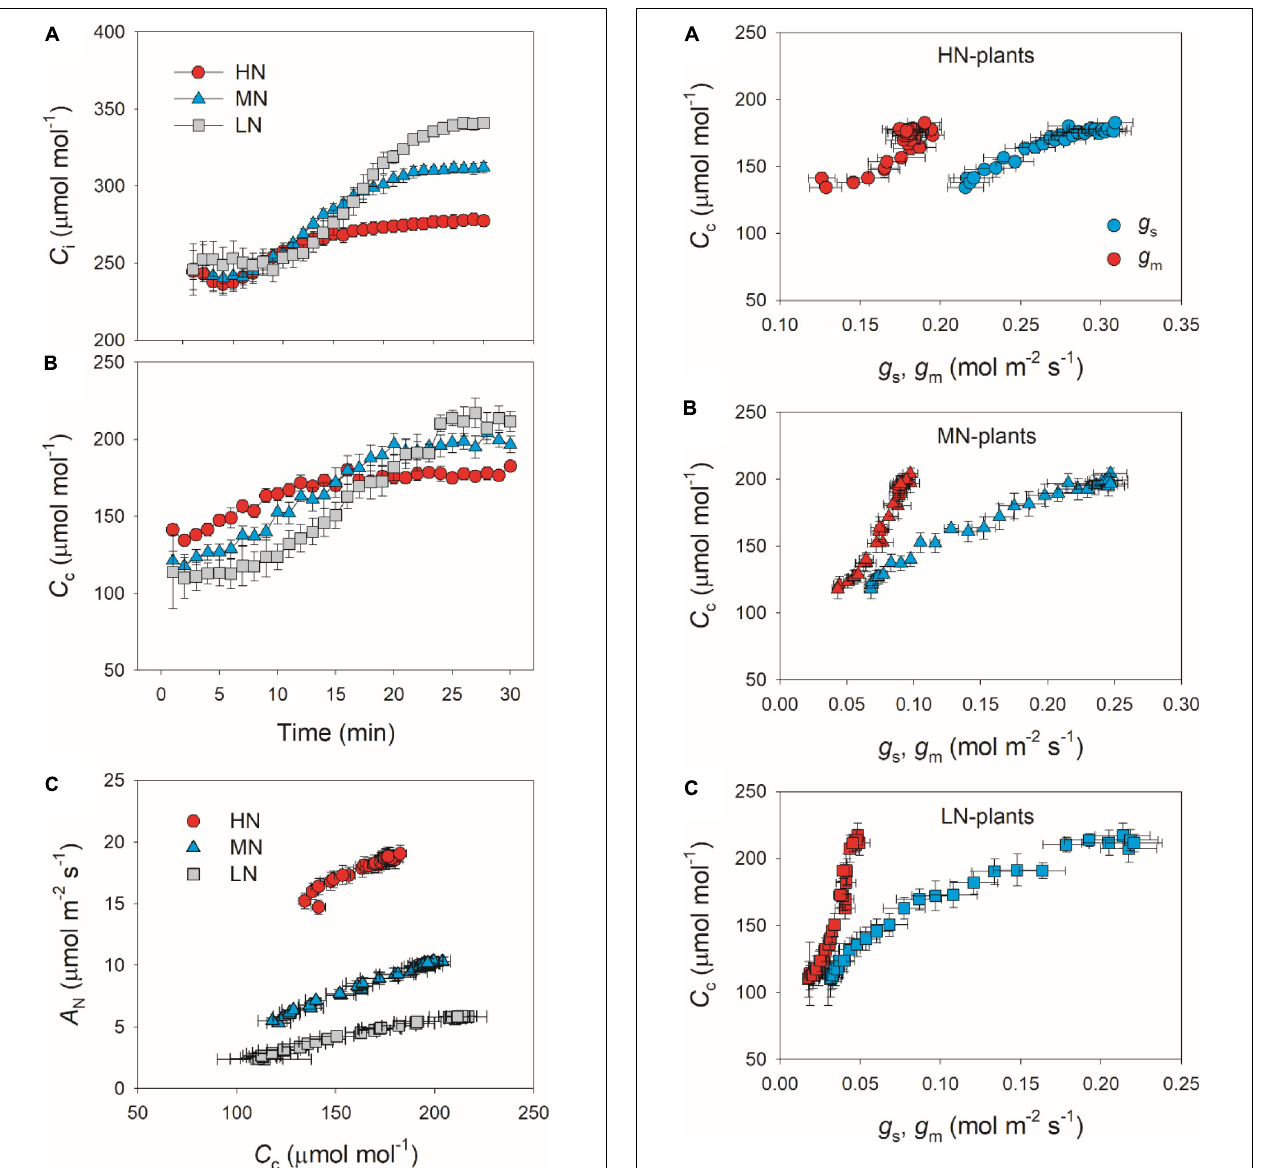
FIGURE 4 | (A,B) Response of intercellular CO 2 concentration ( C i ) and chloroplast CO 2 concentration ( C c ) after transition from 50 to 1,500 µ mol photons m − 2 s − 1 . (C) Relationship between C c and A N after transition from 50 to 1,500 µ mol photons m − 2 s − 1 . Values are means ± SE ( n = 5). HN, MN, and LN represent tomato plants grown under high, medium, and low N concentrations, respectively.